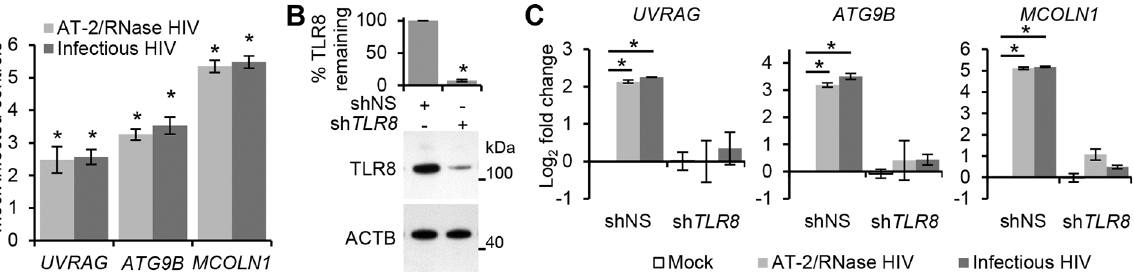
Fig 6. HIV-mediated autophagy and lysosomal gene expression is dependent upon TFEB. (A) qRT-PCR analysis of mRNA expression of autophagy ( UVRAG and ATG9B ) and lysosomal ( MCOLN1 ) genes 24 h post-exposure to mock, infectious, or RNase/DNase I treated AT-2-inactivated purified HIV. Data are reported as mean ± s.e.m., n = 4. (B) Macrophages were transduced with non-specific scrambled shRNA (shNS), or TLR8 shRNA (sh TLR8 ) and analyzed for TLR8 expression. Bottom , a representative blot is shown. Top , densitometric analysis of immunoblots from independent donors presented as means ± s.e.m., n = 4. (C) Macrophages from (B) were exposed to mock, infectious, or RNase/DNase I treated AT-2-inactivated purified HIV for 24 h. Cells were harvested and qRT-PCR for UVRAG , ATG9B , MCOLN1 was performed. Data were normalized to the shNS mock infected control for each gene. Bar charts are reported as mean ± s.e.m., n =